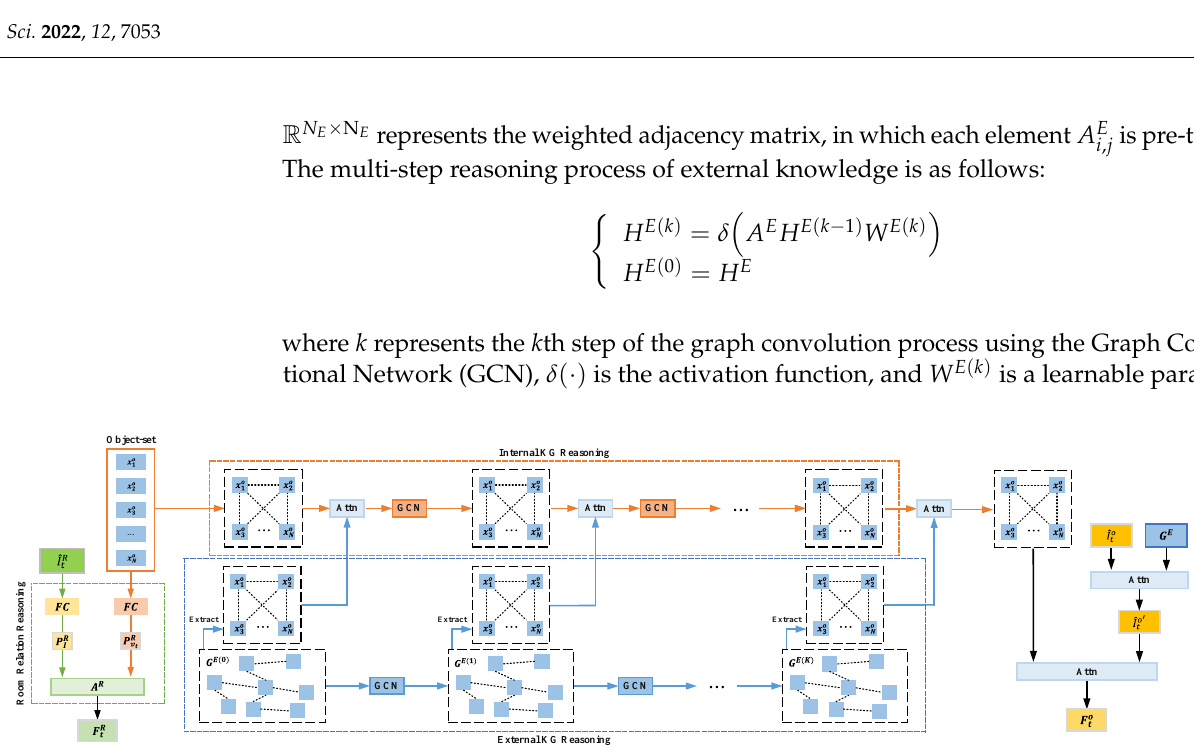
Figure 3. Illustration of the AIEPKR